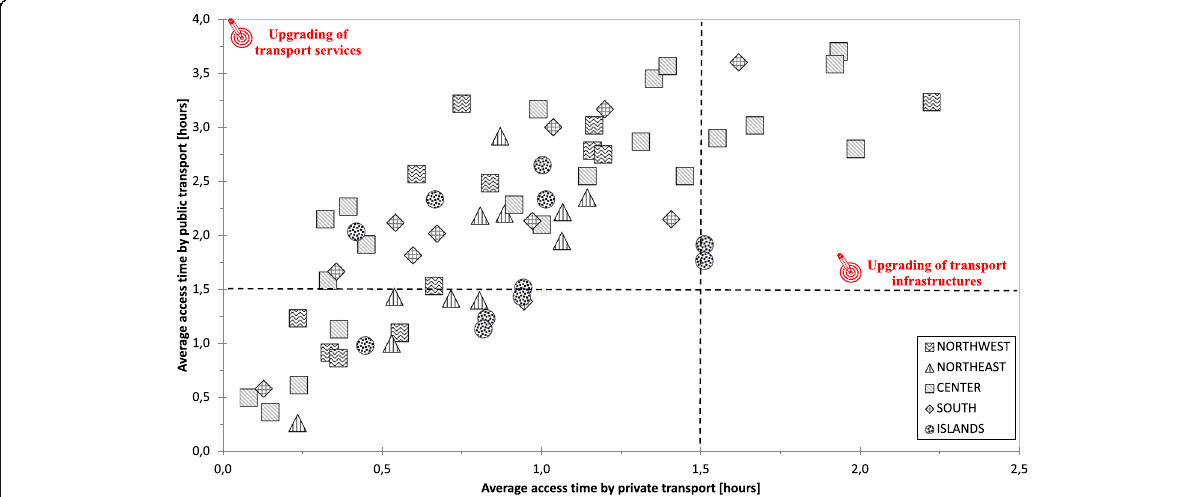
Fig. 9 AG Diagram (from the main national